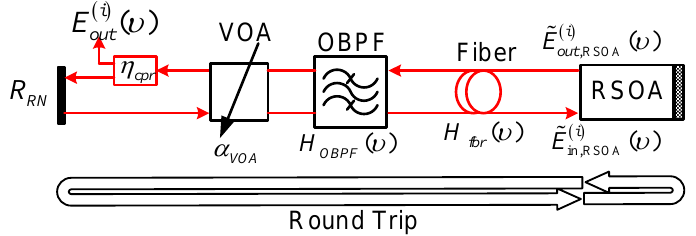
Figure 4. Simplified RSOA-FCL simulation schematics: the RSOA mirror and a remote R form the fiber Fabry-Perot resonator cavity. The optical mirror with reflectivity RN bandpass filter (OBPF) and the variable optical attenuator (VOA) represent the WDM filter and the cavity losses, respectively.